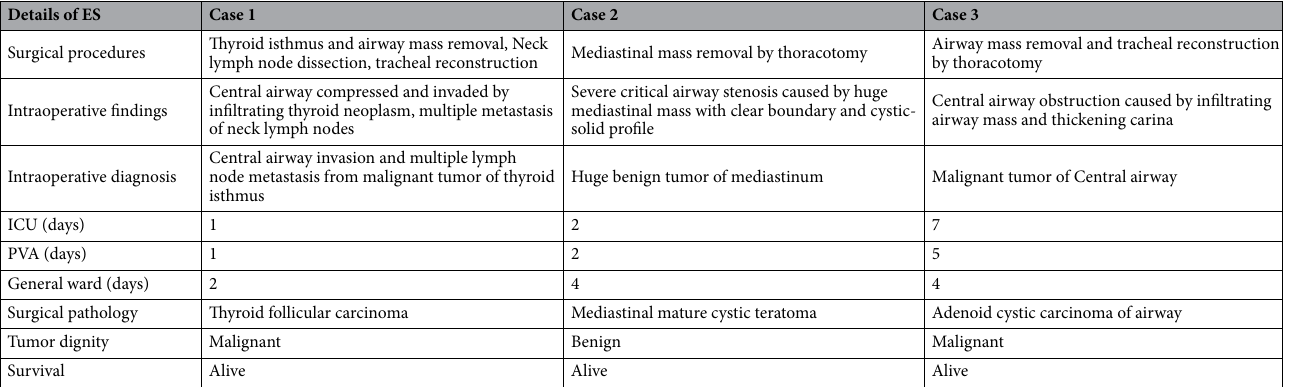
Table 4. Surgical details of patients. ES, emergency surgery; ICU, intensive care unit; PAV, postoperative assisted